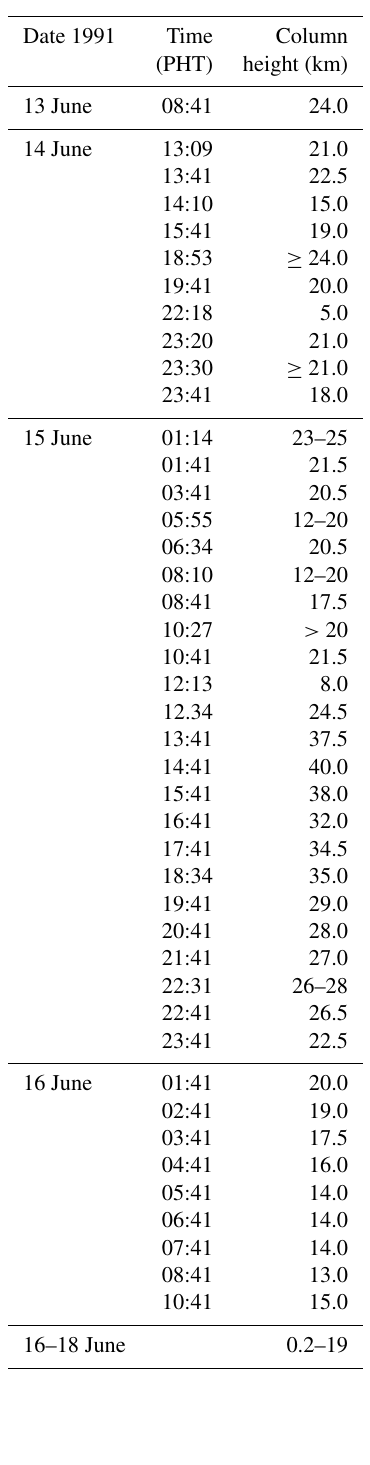
Table A1. Chronology of eruption column heights between 13 June 06:00 and 18 June 00:00. Data compiled from Holasek et al. (1996) and Self et al.